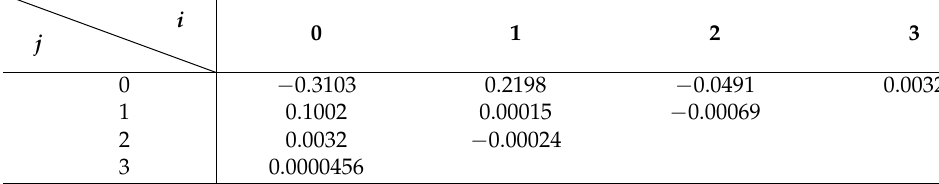
Table 1. Fitting coefficients of C L .